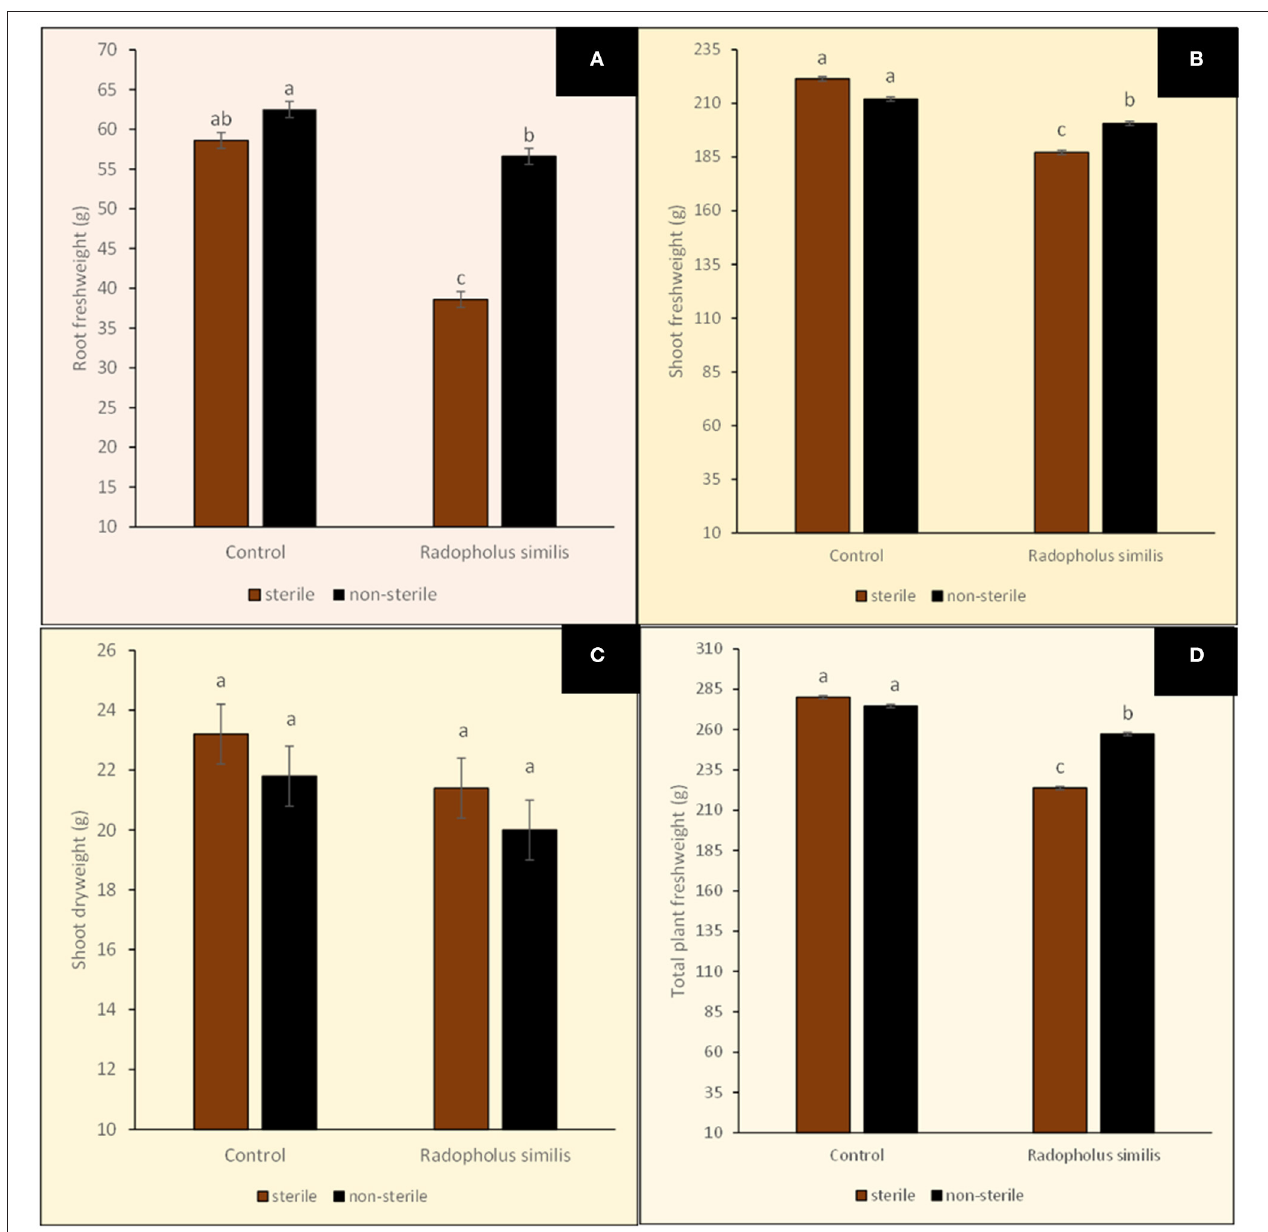
FIGURE 5 | Biomasses of potted tissue culture banana plants either inoculated with Radopholus similis or not inoculated with the nematode and grown in either sterile soil or non-sterile soil supplied with complete nutrient solution. (A) Root freshweight, (B) Shoot freshweight, (C) Shoot dryweight, and (D) Total plant freshweight. Bars with the same letter represent values that are not statistically different ( p > 0.05; more details in Table 1